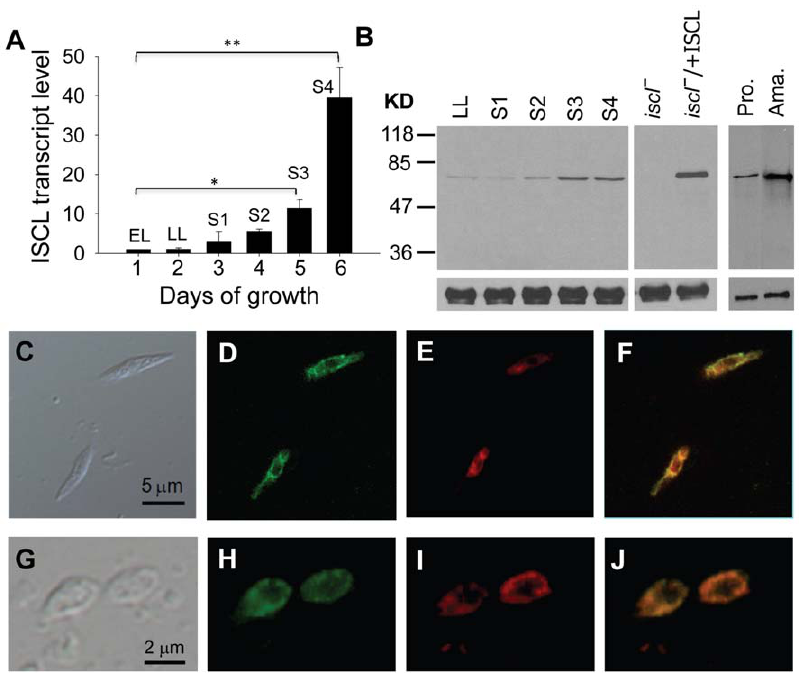
Figure 1. Temporal and spatial expression of ISCL in L.major . ( A ) Elevated ISCL transcript level in stationary phase promastigotes. L. major WT promastigotes were cultured in M199 medium at a starting density of 1.0 6 10 5 cells/ml and total RNA was extracted daily. The relative abundance of ISCL mRNA was determined by quantative RT-PCR using the constitutively expressed rRNA45 gene as an internal control. EL: early log phase culture (1–2 6 10 6 cells/ml); LL: late log phase culture (6–10 6 10 6 cells/ml); S1–S4: day 1–4 stationary phase culture (2.0–3.0 6 10 7 cells/ml). *: p , 0.05, **: p , 0.01. Error bars represent standard deviations from two independent experiments. ( B ) Increased expression of ISCL protein in stationary phase promastigotes and lesion amastigotes. Left: whole cell lysates from WT late log phase promastigotes (LL), day 1–4 stationary phase promastigotes (S1–S4), and late log phase promastigotes of iscl 2 and iscl 2 / + ISCL were subjected to immunoblot analysis using the affinity purified anti-ISCL antibody (top) or an anti- a -tubulin antibody as loading control (bottom). Right: immunoblot of cell lysates from WT day 3 stationary phase promastigotes (S3 pro.) and lesion amastigotes (ama.). Each lane contained material from 1 6 10 6 cells. ( C–J ) Localization of endogenous ISCL in L. major . WT promastigotes ( C–F ) and amastigotes ( G–J ) were fixed and permeabilized with ethanol as described in MaterialsandMethods . Cells were then labeled with rabbit anti-ISCL antibody, followed by staining with goat-anti-rabbit IgG-FITC ( D , H ) and Mitotracker Red 580 ( E , I ). ( F ) Overlay of D and E . ( J ) Overlay of H and I . Control cells that were labeled with secondary antibody only did not show any green fluorescence (data not shown). Experiments in C–F were performed three times and results from one representative set are shown here.